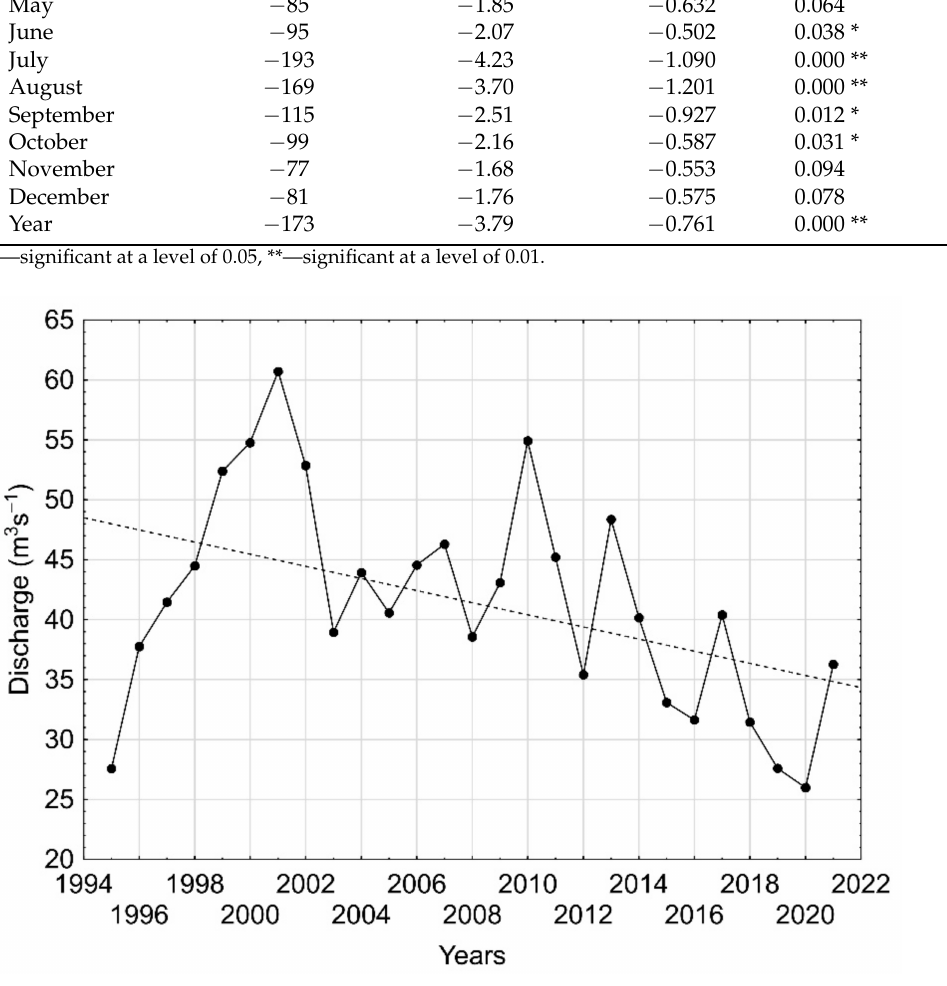
Figure 7. Changes in mean annual water flows through the Jeziorsko hydropower plant in the period